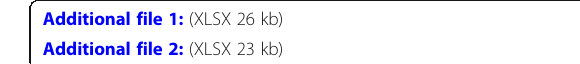
Abbreviations DALY: Disability-adjusted life years; DW: Disability weight; EMR: Eastern Mediterranean Region; GBD: Global Burden of Disease Study; IHME: Institute for Health Metrics and Evaluation; LDI: Lag-distributed income; MOH: Medication overuse headache; SDI: Socio-demographic Index; SSA: Sub-Saharan Africa; TFR: Total fertility rate; TTH: Tension-type headache;